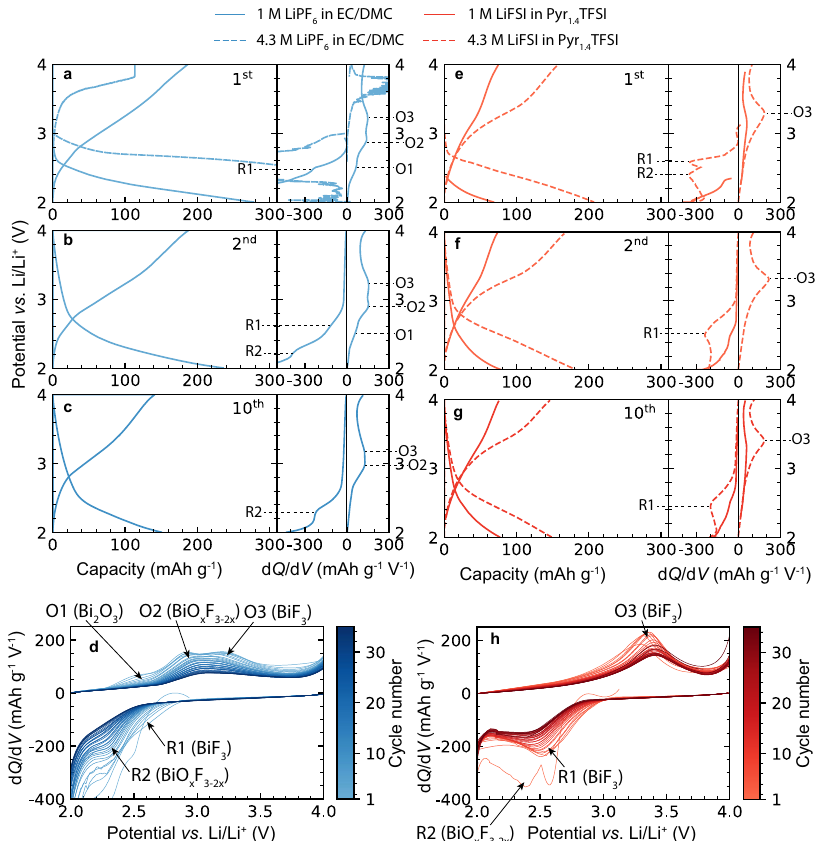
Fig. 4 Electrochemical performance. Charge and discharge voltage pro fi les and associated dQ/dV curves of BiF 3 cathode measured in LiPF 6 (1M and 4.3M)- EC/DMC and LiFSI (1M and 4.3M)-Pyr 1,4 TFSI Li-ion electrolytes for the fi rst ( a , e ), second ( b , f ) and tenth ( c , g ) cycles. Combined d Q /d V plots measured upon cycling of BiF 3 cathode in 1M LiPF 6 -EC/DMC Li-ion electrolyte for fi rst the 35 cycles; ( d ) and 4.3M LiFSI ( h ) in Pyr 1,4 TFSI Li-ion electrolytes. The BiF 3 /Li half cells were cycled at a current density of 30mAg − 1 in the voltage range of 2 ‒ 4V vs. Li + /Li. The electrochemical performance of BiF 3 measured in other carbonate-based electrolytes (1M LiPF 6 in EC/DMC + 3 wt-% FEC, EMC and EMC + 3 wt-% FEC) is given in Supplementary Fig. S14 for comparison.